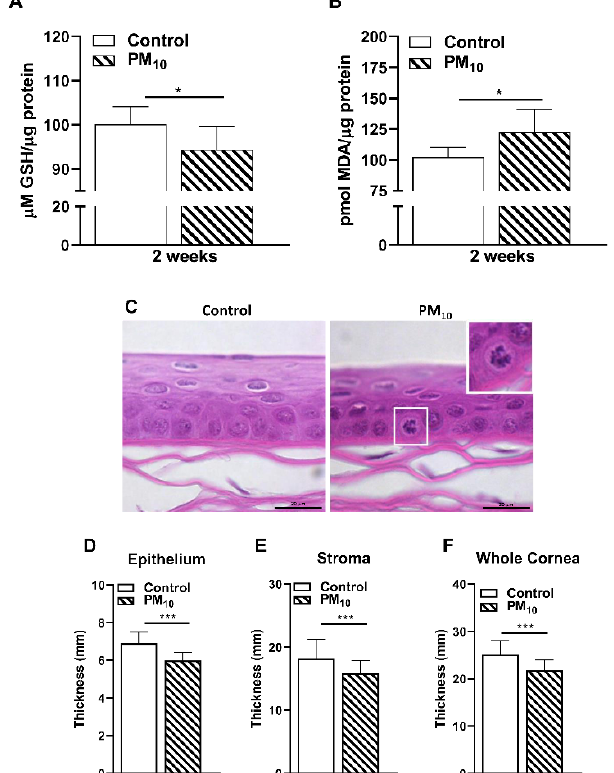
Figure 2. Effects of PM 10 exposure: oxidative stress and histology. ( A ) Levels of GSH were significantly lower after 2 weeks exposure to PM 10 vs. control. ( B ) MDA levels (lipid peroxidation end product) were significantly increased in PM 10 vs. control exposed corneas after 2 weeks. ( C ) Paraffin embedded and hematoxylin and eosin stained corneas after 2 weeks exposure to PM 10 or control. Inset shows an infiltrating cell containing a brownish particulate. Scale bar = 20 µ m. Thickness of the epithelium ( D ), stroma ( E ) and the whole cornea ( F ) were significantly decreased in PM 10 vs. control exposed corneas. Data are expressed as mean + SD. (* p < 0.05, n = 5/group ( A , B ) *** p < 0.001, n = 3/group ( D – F )).